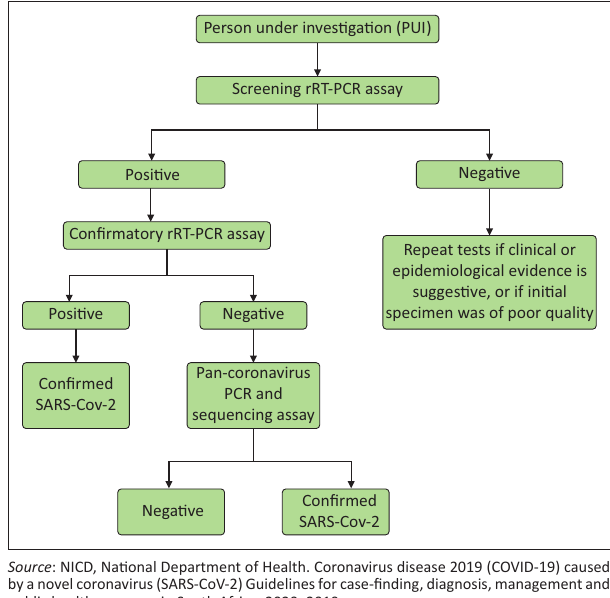
FIGURE 1: Spectrum of clinical presentation and progression of severe acute respiratory syndrome coronavirus